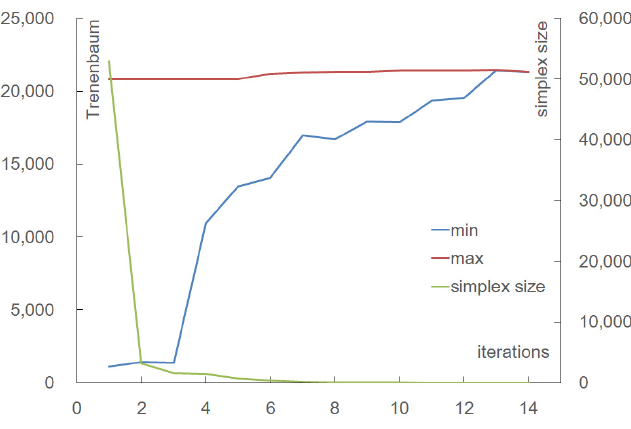
Figure 6. Convergence of Tenenbaum gradient and simplex size.